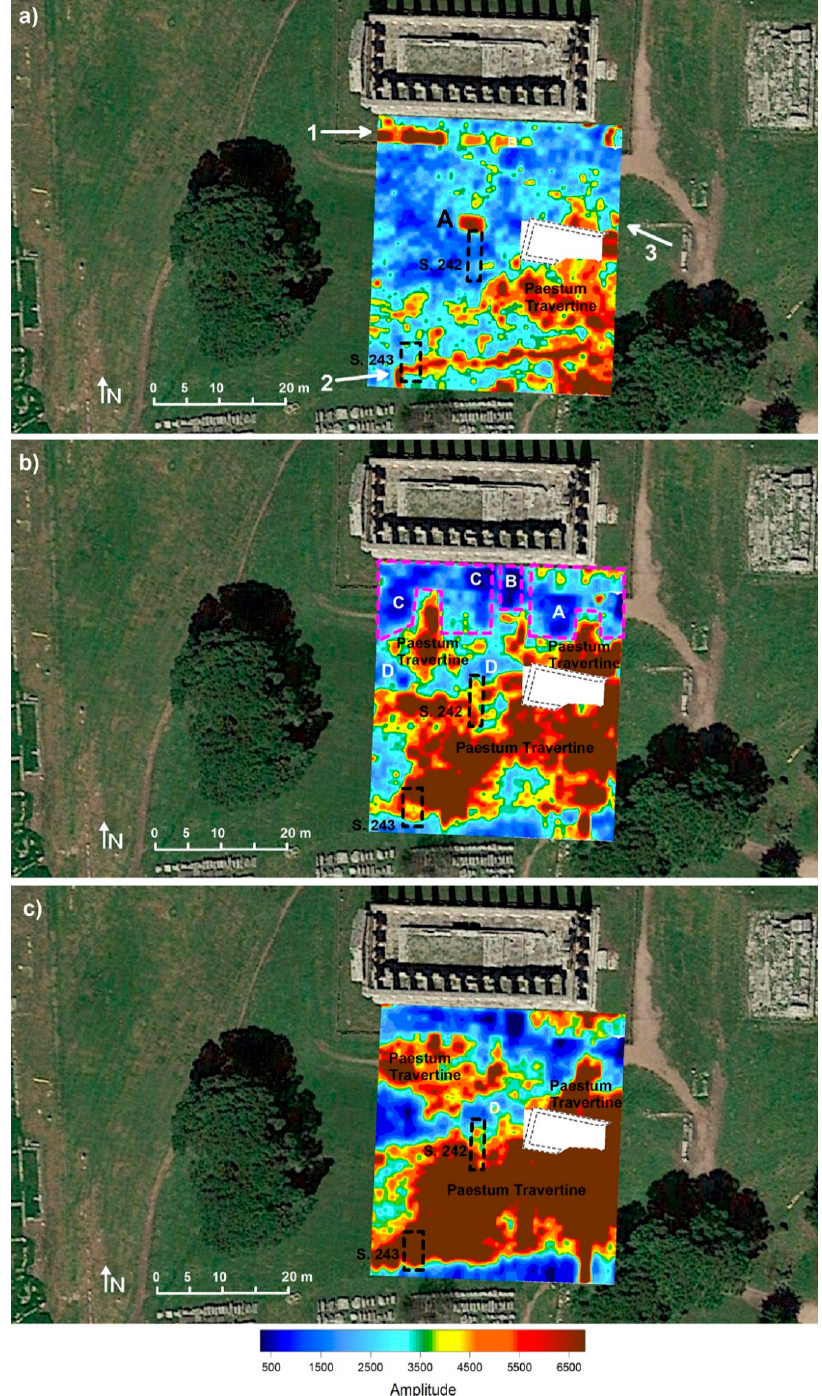
Figure 9. GPR horizontal slices superimposed on a Google Earth TM satellite image; the slices are relative to the depth ranges 0.2–0.4 m ( a ), 1–1.2 m ( b ) and 2–2.20 m ( c ).